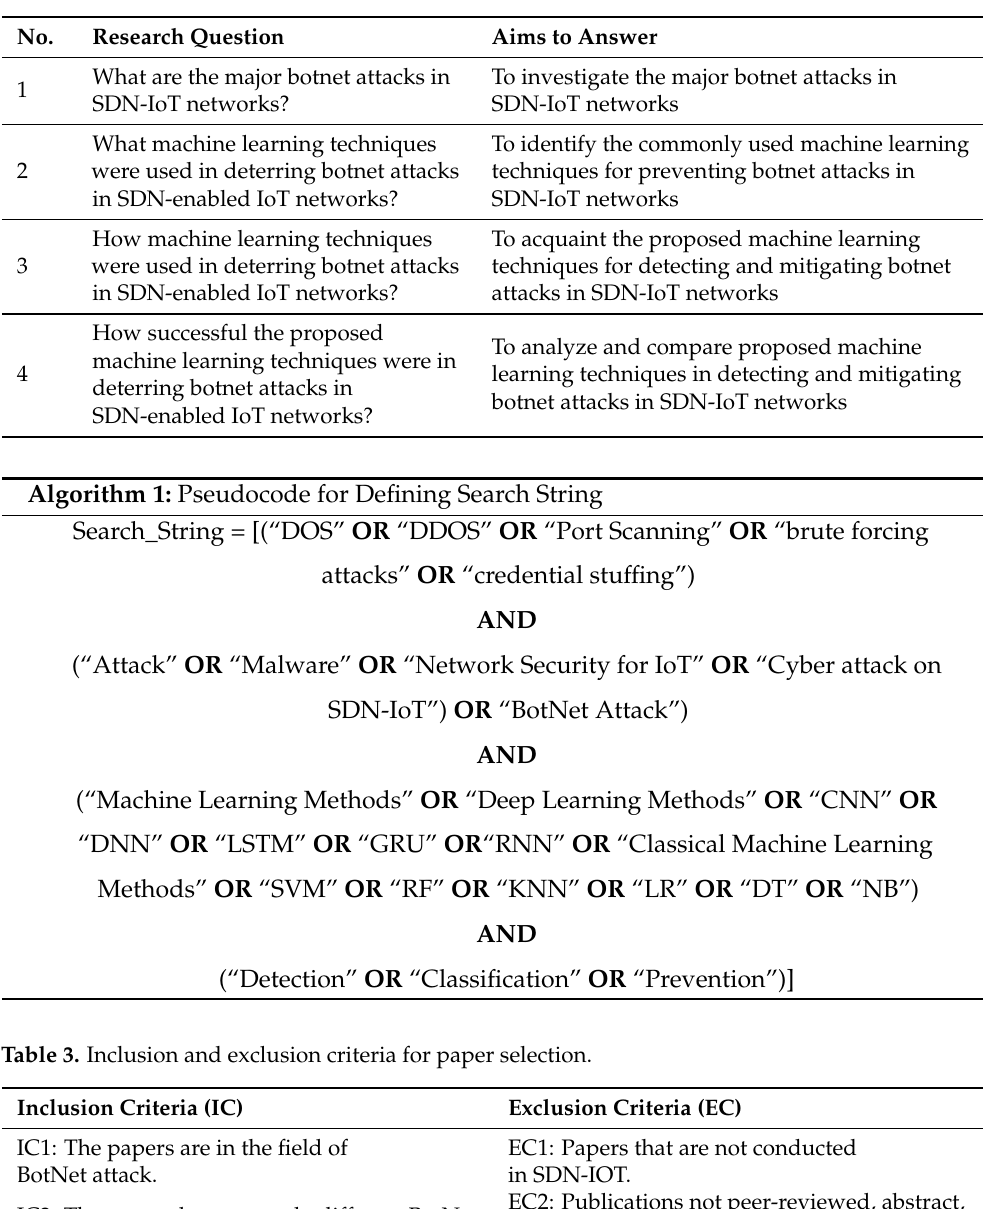
Table 2. Research questions for the review.